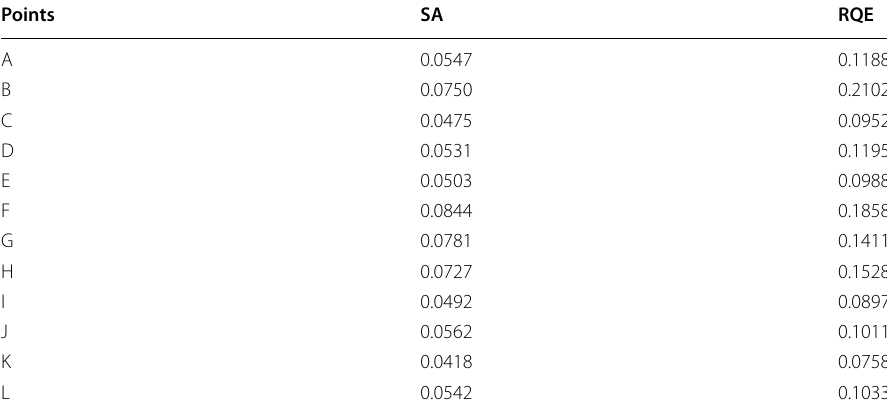
Table 2 The evaluations for the spectral curves Points SA